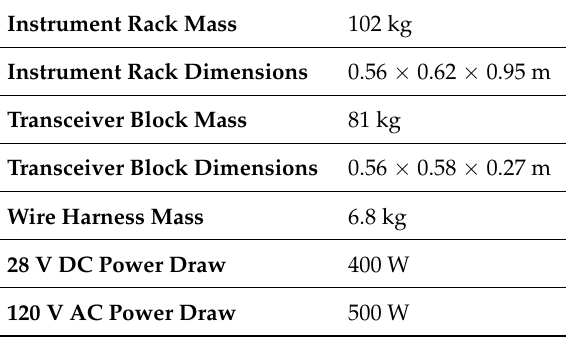
Table 1. Instrument summary mass, power, and